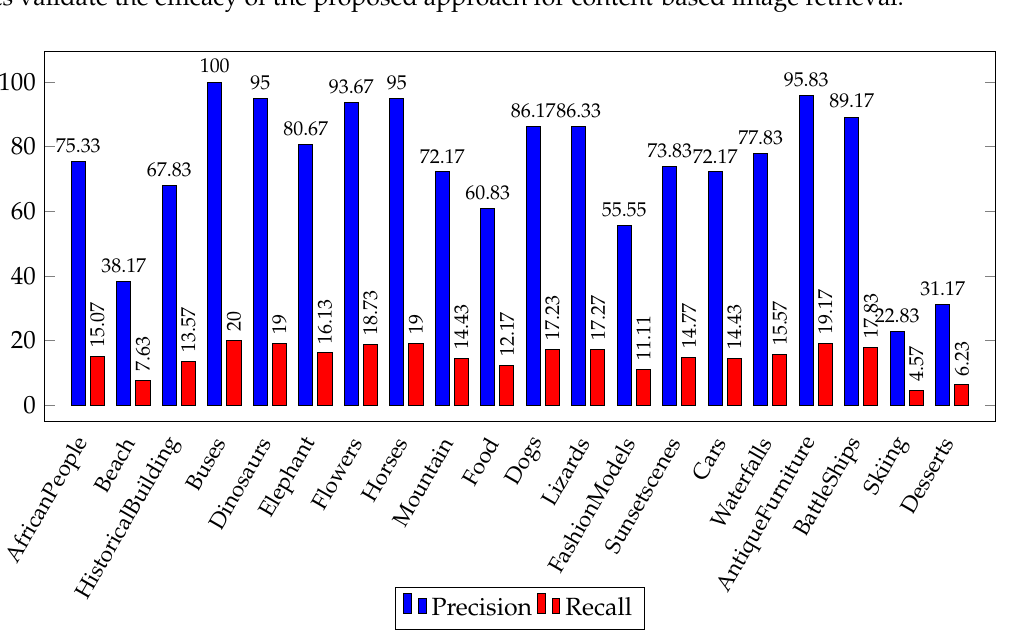
Figure 13. Average Precision and Recall of the proposed RGSIR for the top 20 retrievals using Corel-2K image becnchmark. Table 4. Comparison of the mean average precision using Corel-2K image